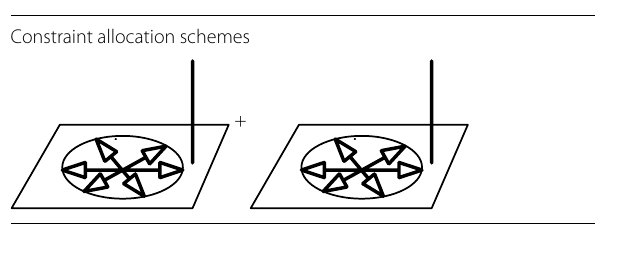
Table 7 Constraint allocation schemes Constraint allocation schemes